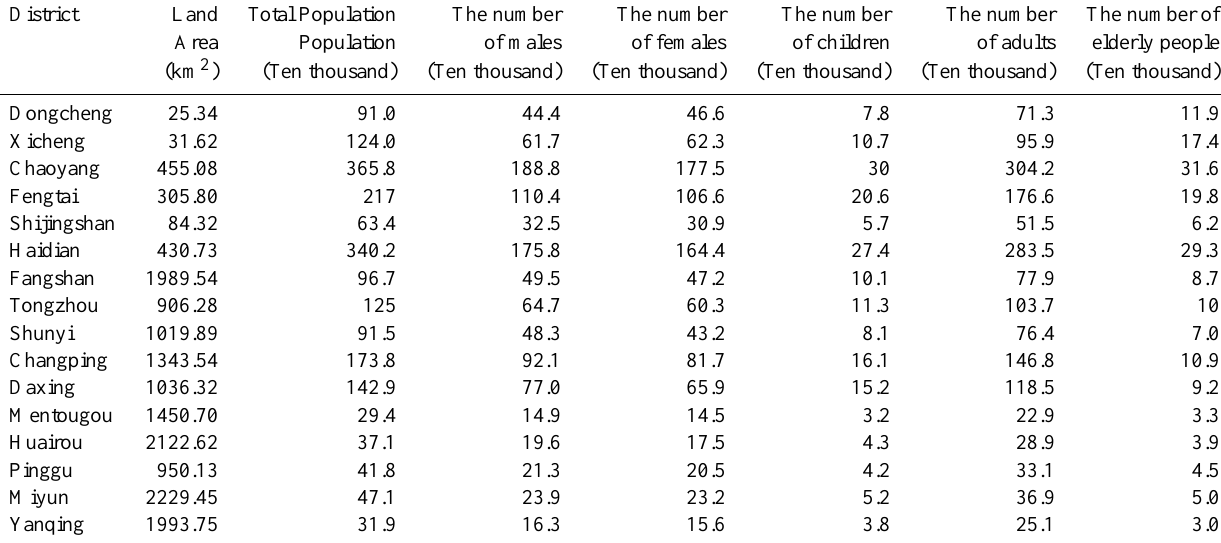
Table 1. The distribution of population and land area in the eight affected districts in 2012. District Land Total Population The number The number The number The number The number of Area Population of males of females of children of adults elderly people (km 2 ) (Ten thousand) (Ten thousand) (Ten thousand) (Ten thousand) (Ten thousand) (Ten thousand)